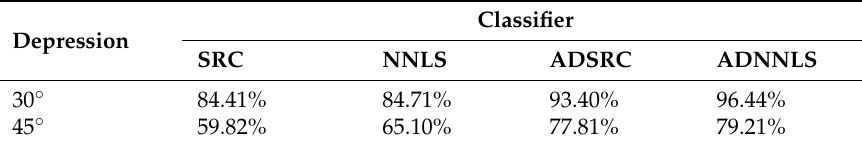
Table 3. Recognition rates under different depression angles with four